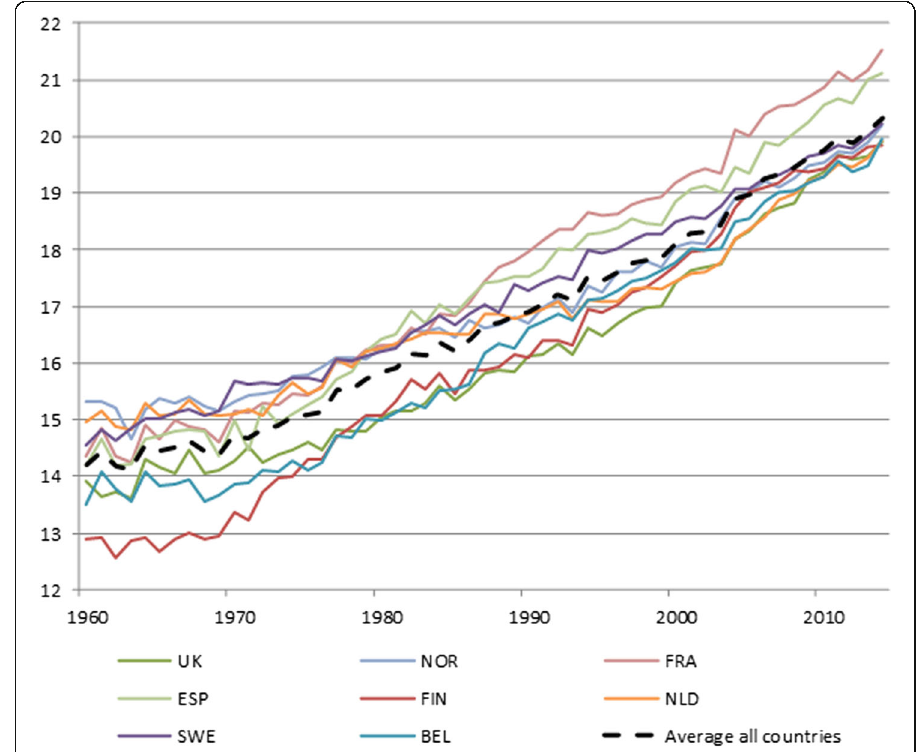
Fig. 1 Life expectancy at age 65, 1960 – 2014 for eight countries, men and women